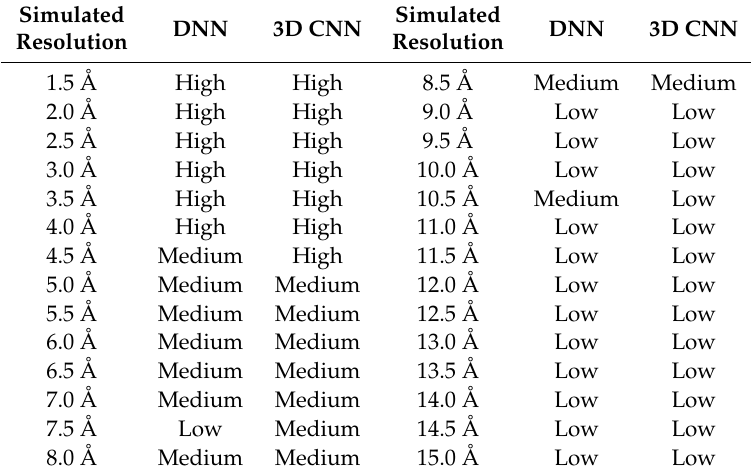
Table 1. Classification results on simulated maps with varying resolution for dense artificial neural network (DNN) and convolutional neural network (3D